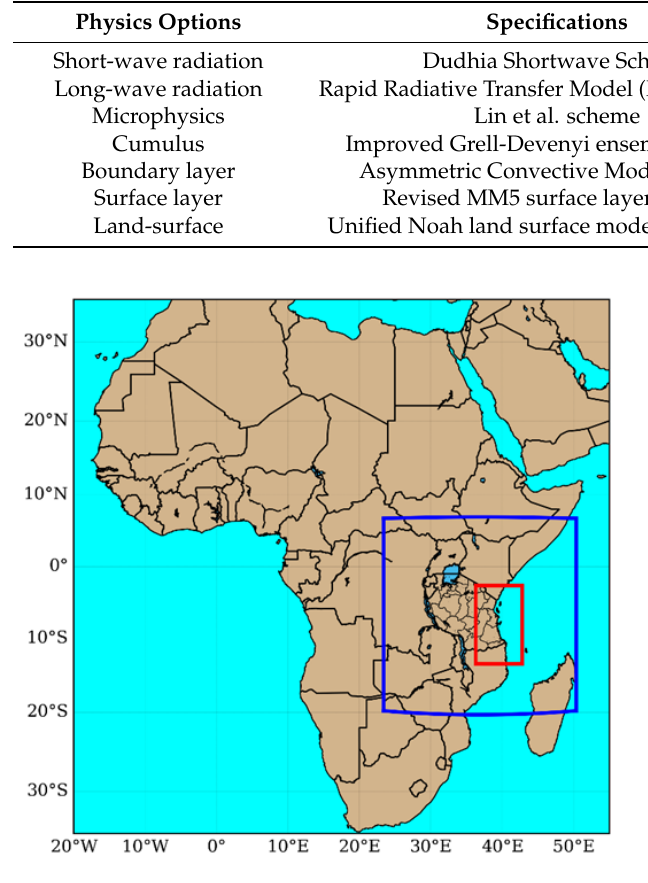
Figure 2. Domain for WRF model run. The resolution of outer domain is 12 km (blue), and that of inner domain is 4 km (red). Table 1. Model physics options.